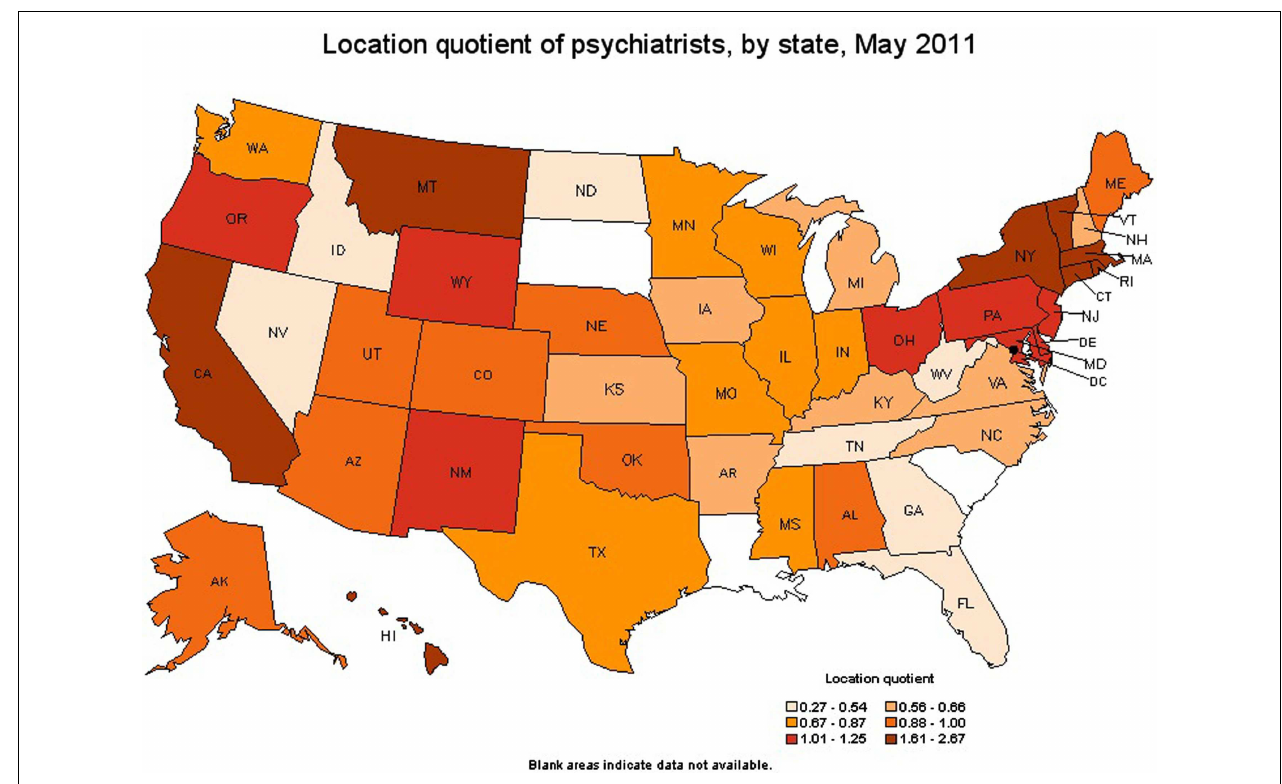
FIGURE 1 | Geographic profile for psychiatrists by state (http://www.bls.gov/oco/ocos056.htm,